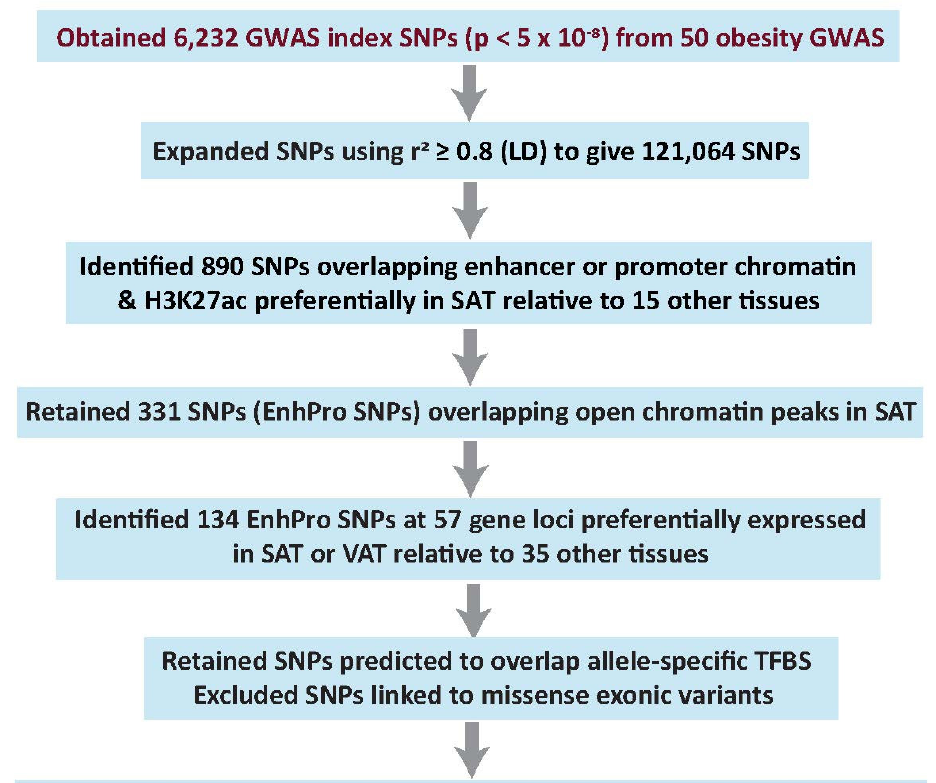
Figure 1. Workflow for prioritizing potential causal regulatory (Tier-1) SNPs from 50 obesity GWAS. Summary of prioritization of plausible regulatory obesity SNPs. LD, linkage disequilibrium; assoc, associated; LD, linkage disequilibrium; H3K27ac, histone H3 lysine-27 acetylation (an epigenetic mark of active enhancers or promoters); SAT, subcutaneous adipose tissue; DHS, DNaseI hypersensitive site (open chromatin); TFBS, transcription factor binding site (s).